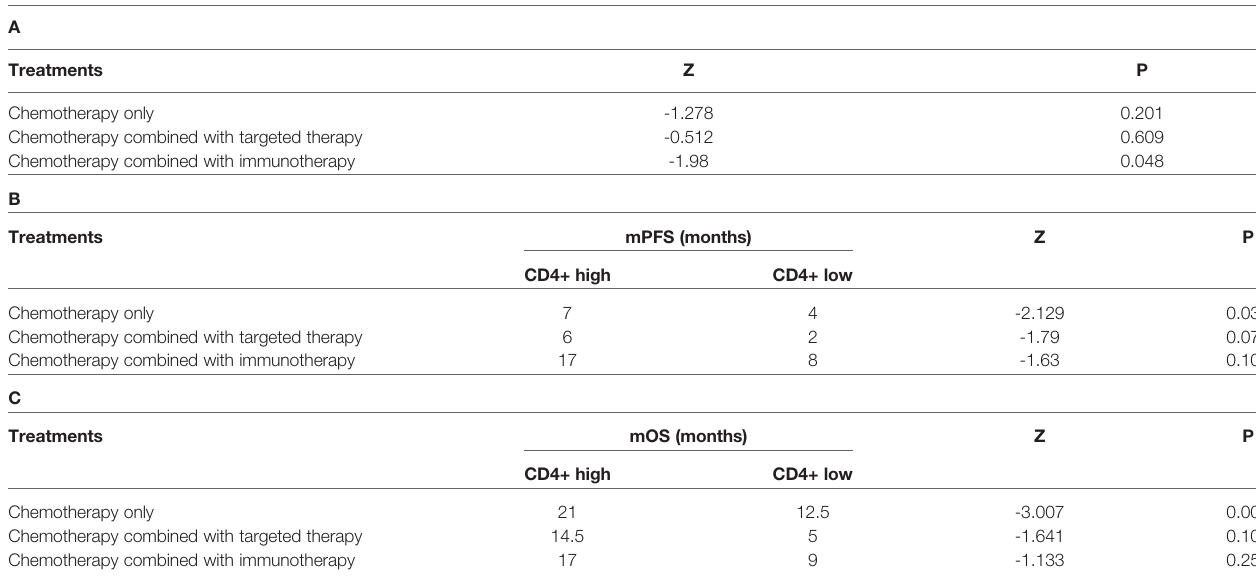
TABLE 4 | Mann ‐ Whitney U test was conducted to detect differences in treatment response (A) , PFS (B) , and OS (C) among the chemotherapy only, chemotherapy combined with targeted therapy, and chemotherapy combined with immunotherapy